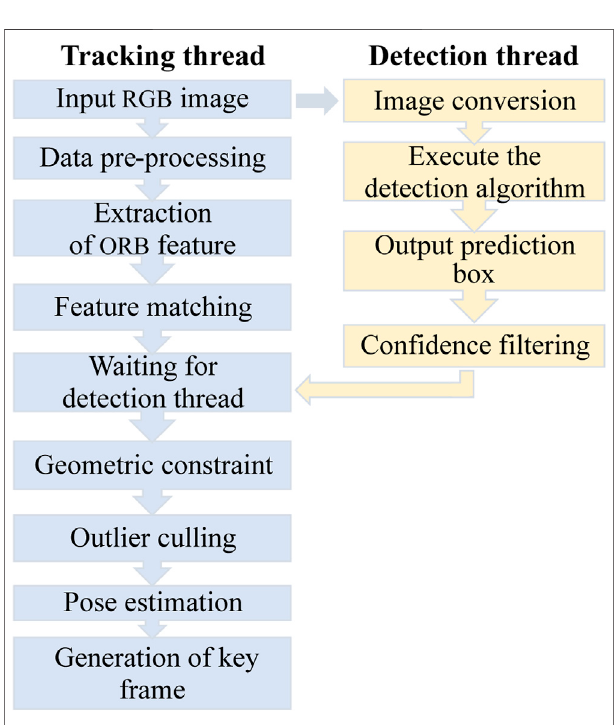
FIGURE 2 | The fl owchart of the improved object detection thread and tracking thread in the proposed algorithm.